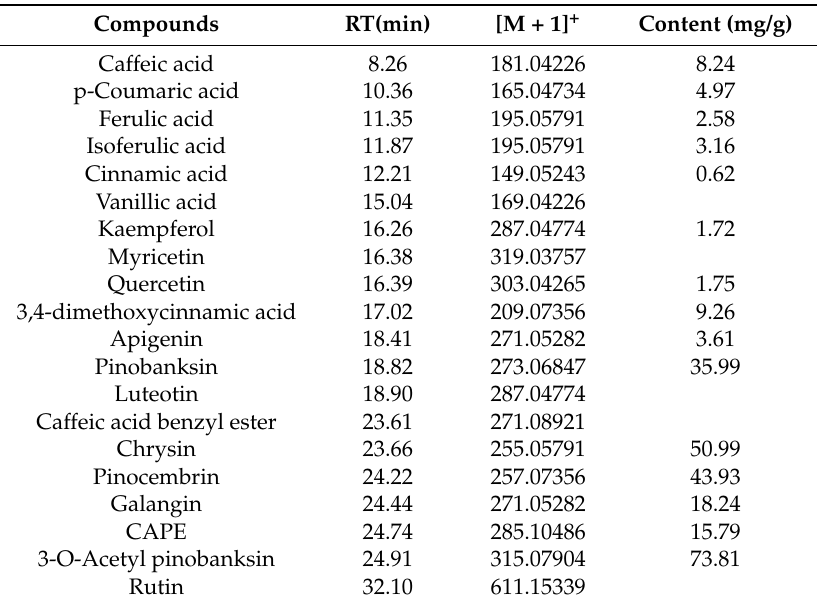
Table 2. The components identified in Chinese propolis